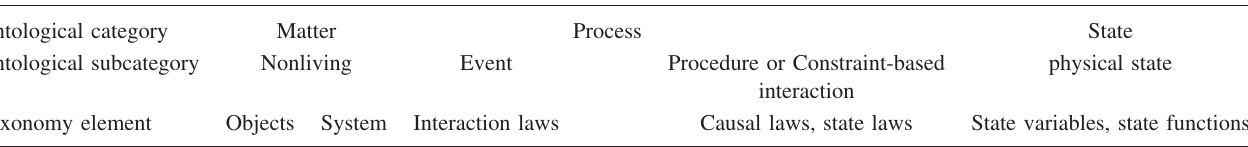
TABLE I. Illustration of how Etkina et al. ’s model taxonomy successfully maps into Chi et al. ’s (cid:1) modified (cid:2) ontology. Ontological category